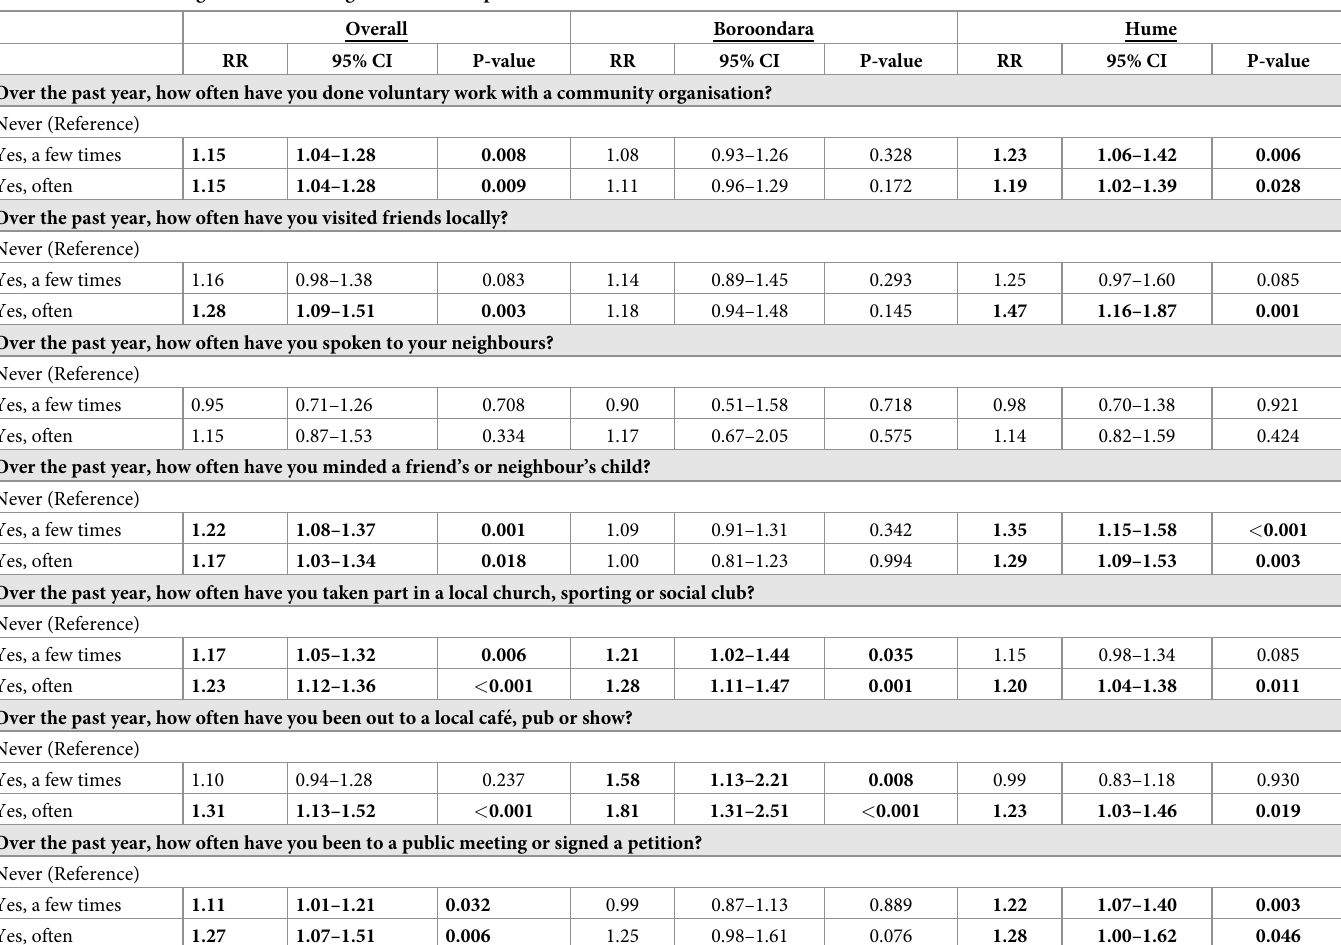
Table 2. Multivariate negative binomial regression results–perceived social